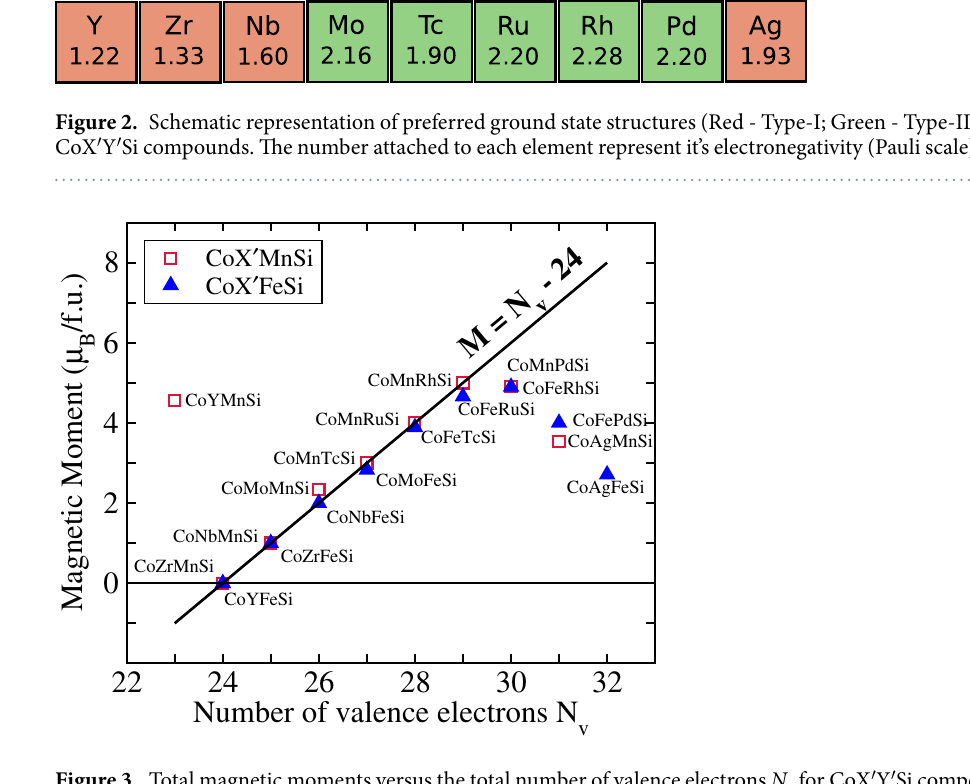
Figure 3. Total magnetic moments versus the total number of valence electrons N ν for CoX ′ Y ′ Si compounds. The Slater-Pauling M = N ν − 24 line is drawn as a guide to understand whether the compounds follow Slater- Pauling